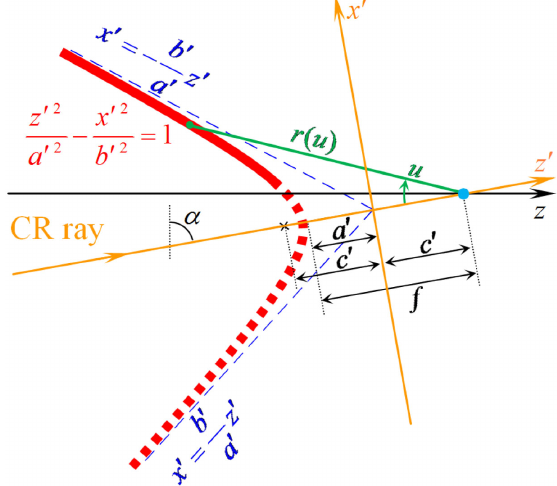
FIG. 6. Detailed description of the outer surface of the con- centrator for